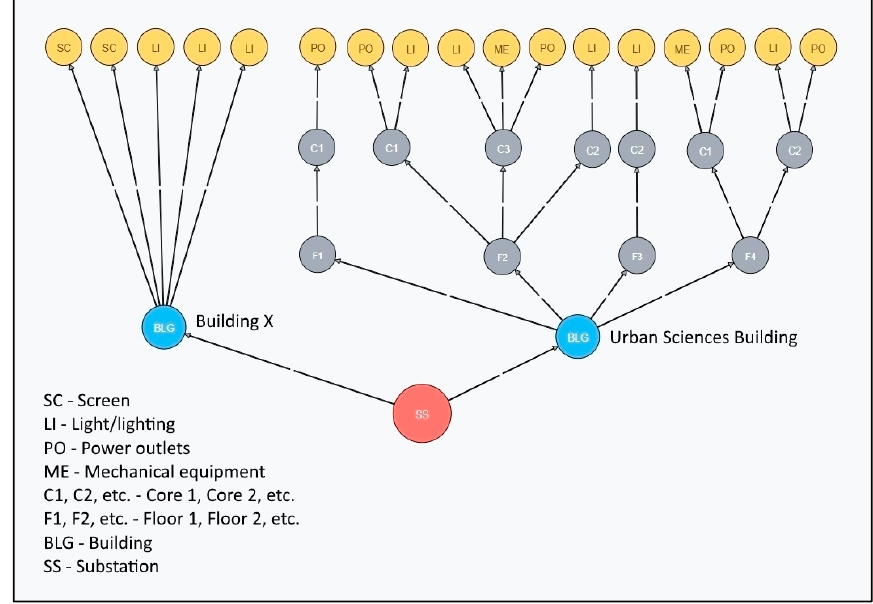
Figure 7. An abstracted, integrated electricity network topology spanning the intra ‐ urban and intra ‐ building scales.